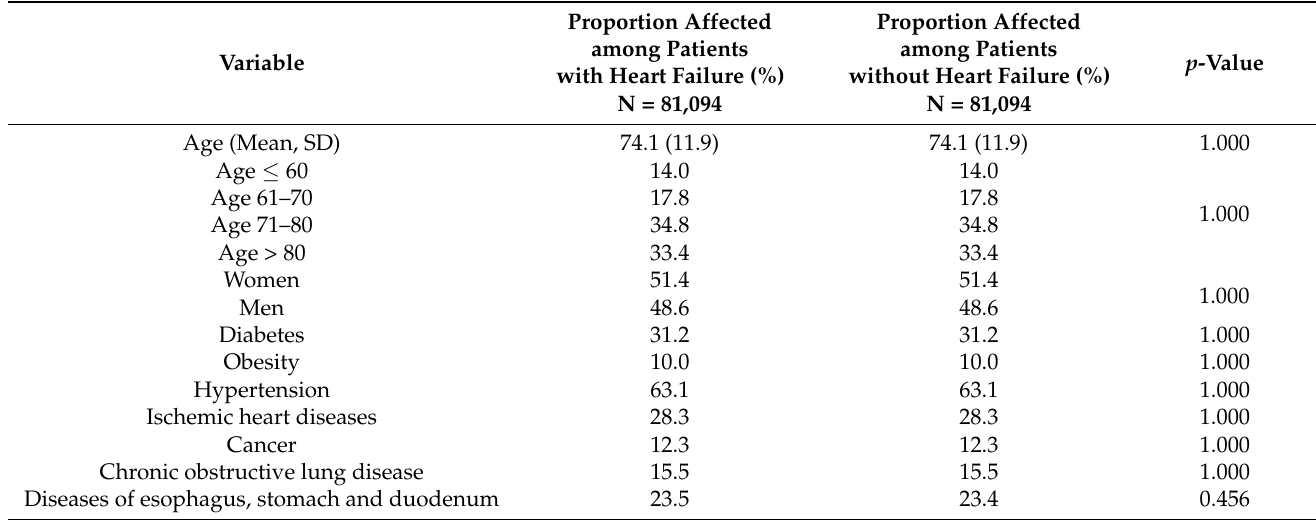
Table 1. Baseline characteristics of the study sample after 1:1 propensity score matching.